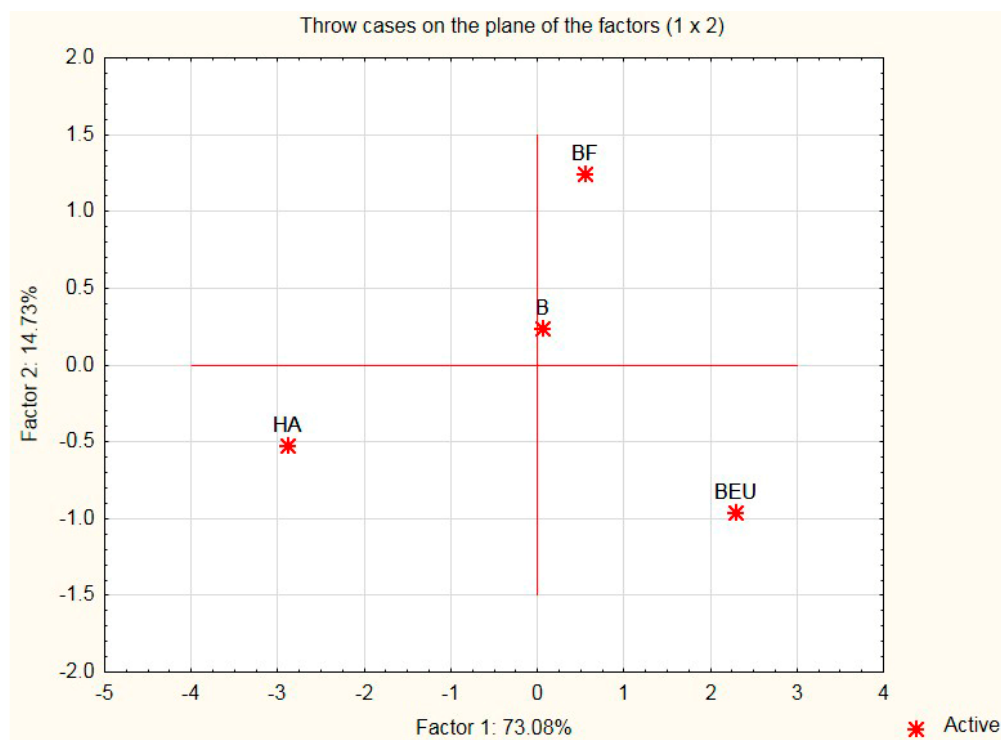
Figure 4. Projection of cases on the plane of factors.